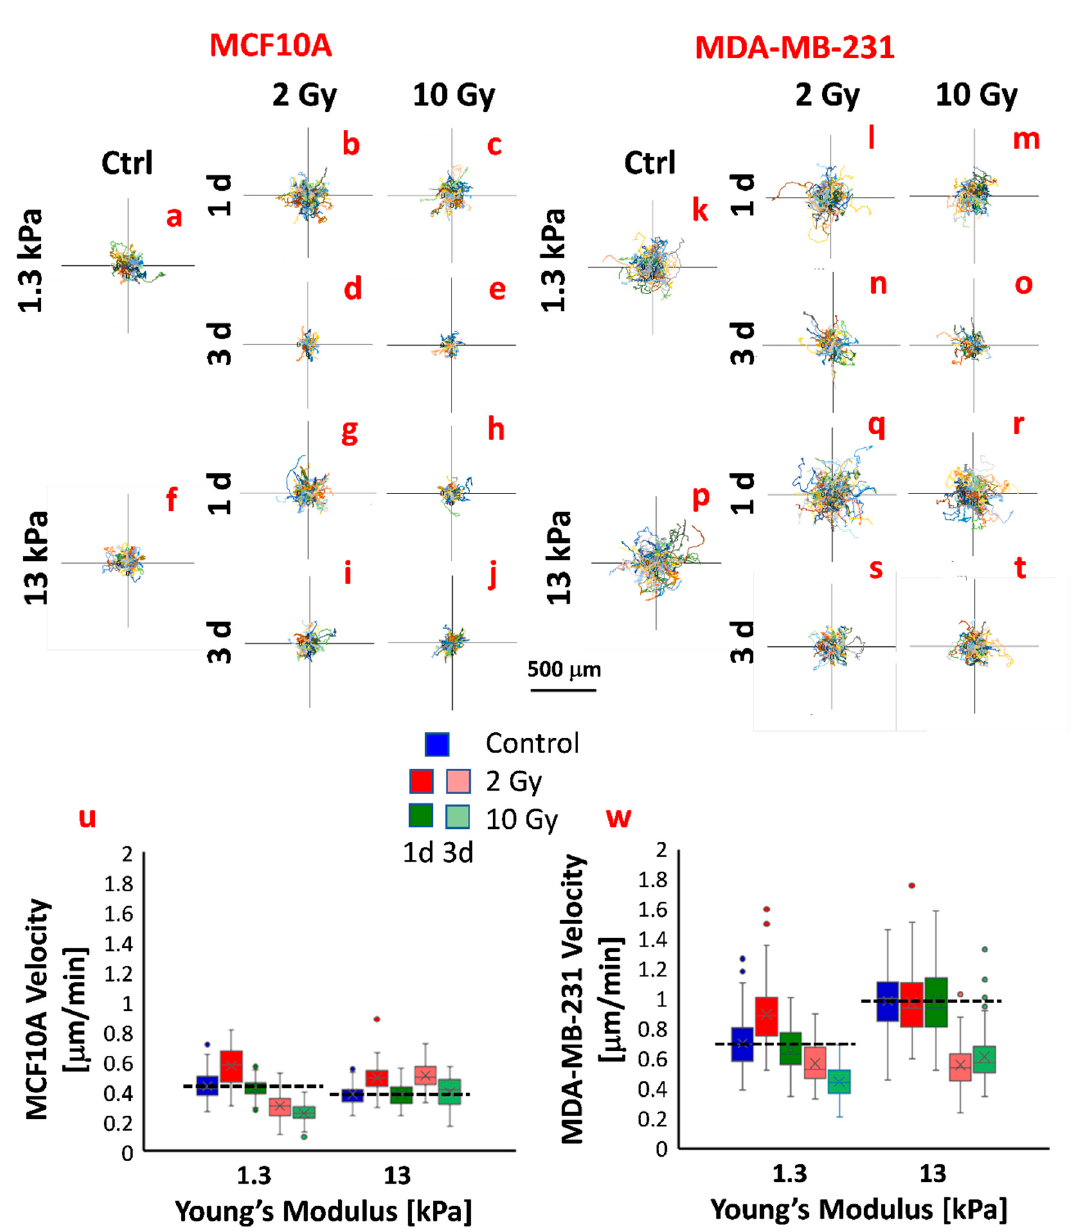
Figure 3. Plot at origin of trajectories of MCF10A and MDA-MB-231 before ( a , f , k , p ) and after RT ( b – e , g – j , l – o , q – t ). Trajectories of cells were obtained by manual tracking using ImageJ and Manual Tracking plugin (http: // rsweb.nih.gov / ij / ). Box plots (mean, median, interquartile range and outliers) of migration velocity of MCF10A ( u ) and MDA-MB-231 ( w ) in all analyzed conditions. Cell velocity was calculated by the trajectories using the formula 1 (see Section 3). Dashed lines ( u , w ) indicate the mean values of velocity in control conditions. n > 58 for all conditions.